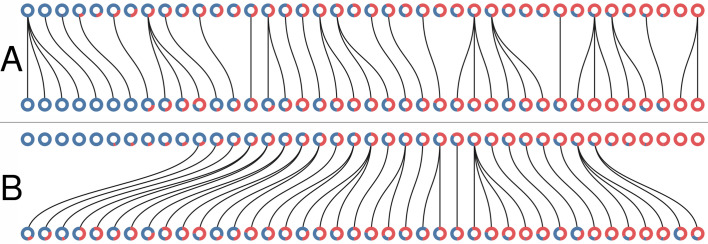
Collective-level selection regimes.Each ring represents a collective. The blue section of the ring represents the proportion of blue particles at the adult stage of the collective. Parent and offspring are linked by a black line. (A) One generation of the neutral regime. (B) One generation of the selective regime. In both cases M=1,D=40,ρ=0.4.